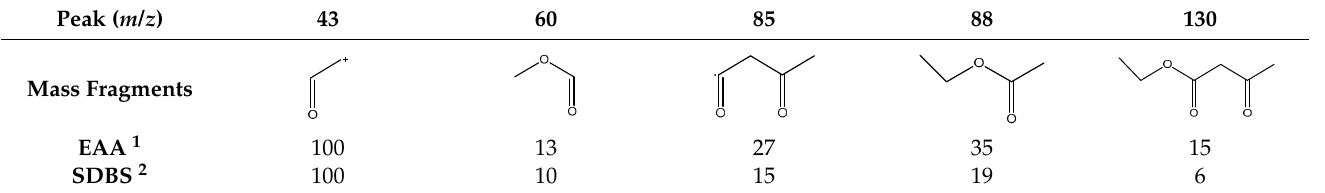
Figure 2. Chromatograms of EAA and spectra of the 1 min peaks. Panel A to C, chromatograms for EAA unheated (Panel ( A )), EAA heated to 73.9 °C (Panel ( B )), and EAA heated to 93.3 °C (Panel ( C )). The x -axis is retention time in min. Panels ( D – F ), spectra of the 1 min peaks from the respective GC. The x -axis is m/z . The EAA molecule integrated in Panel ( A ) was taken from PubChem (https://pubchem.ncbi.nlm.nih.gov/compound/). Table 2. Comparison of the experimental and database mass spectra for EAA. Peak ( m/z )